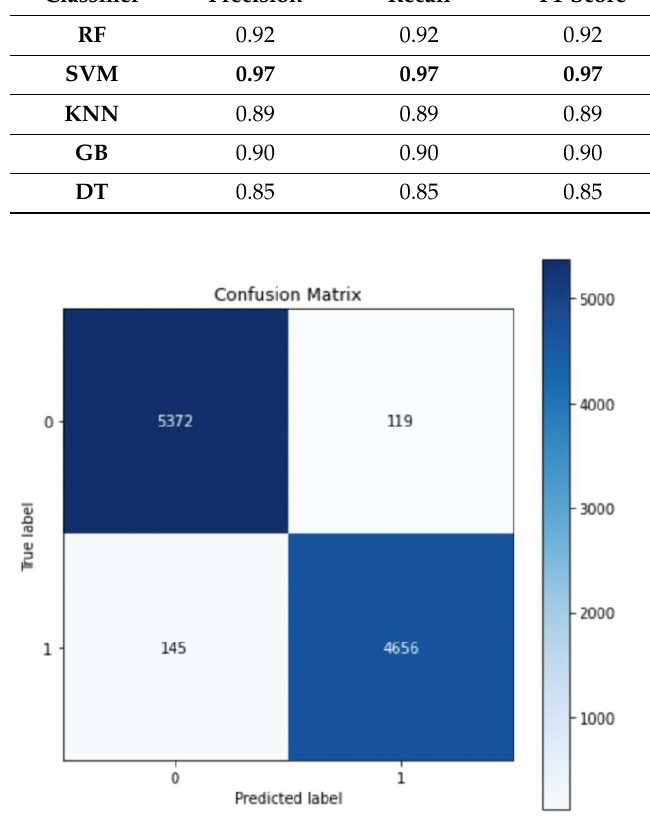
Figure 11. Confusion matrix for